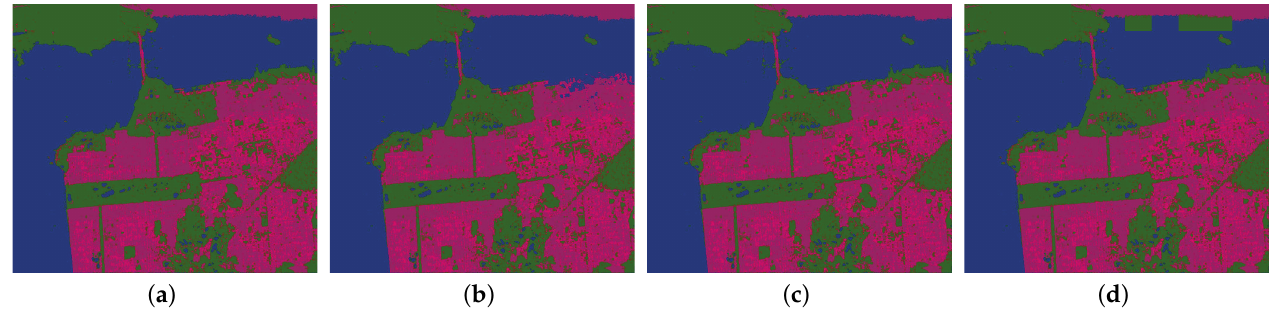
Figure 10. Classification results with different adjacent parameters. ( a ) Result with adjacent parameter 0.25. ( b ) Result with adjacent parameter 0.5. ( c ) Result with adjacent parameter 0.75. ( d ) Result with adjacent parameter 1.00.